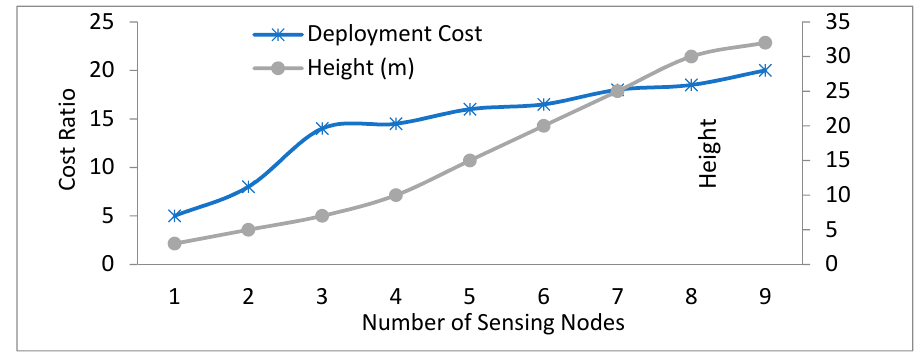
Figure 19. Relationship between number of the sensing nodes, node height and the deployment cost.